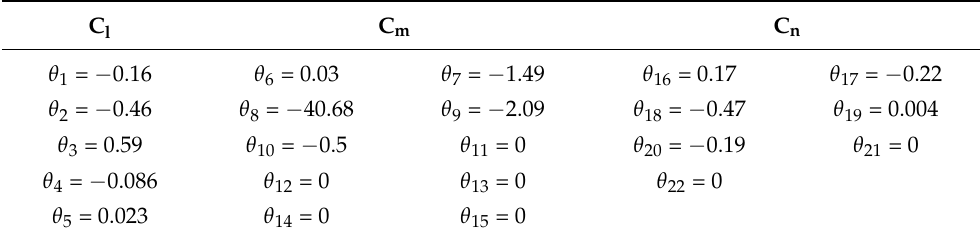
Table 1. Initial values of unknown parameters in generic aerodynamic moment model. C l C m C n θ 1 = −